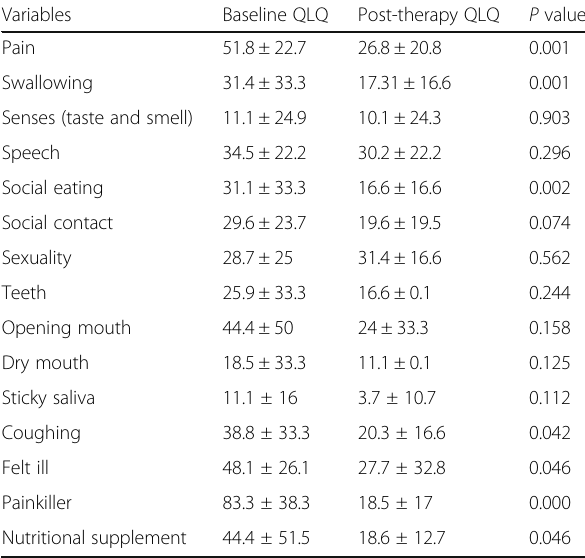
Table 4 EORTC QLQ-H&N35 scoring at the onset and end of assessment in 17 H&N PGL